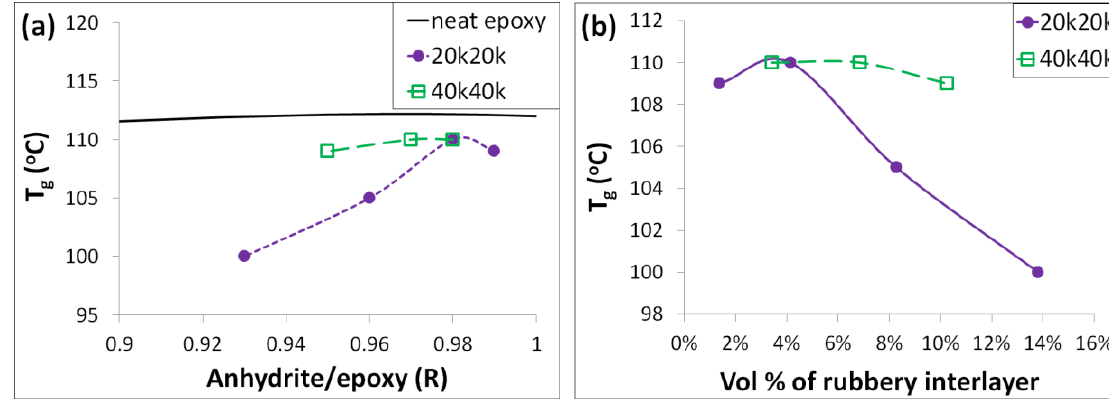
Figure 6. Plots of glass transition temperature vs. ( a ) anhydride/epoxy ratio R of different epoxy systems; ( b ) the rubbery interlayer volume percent in the 20k20k and the 40k40k